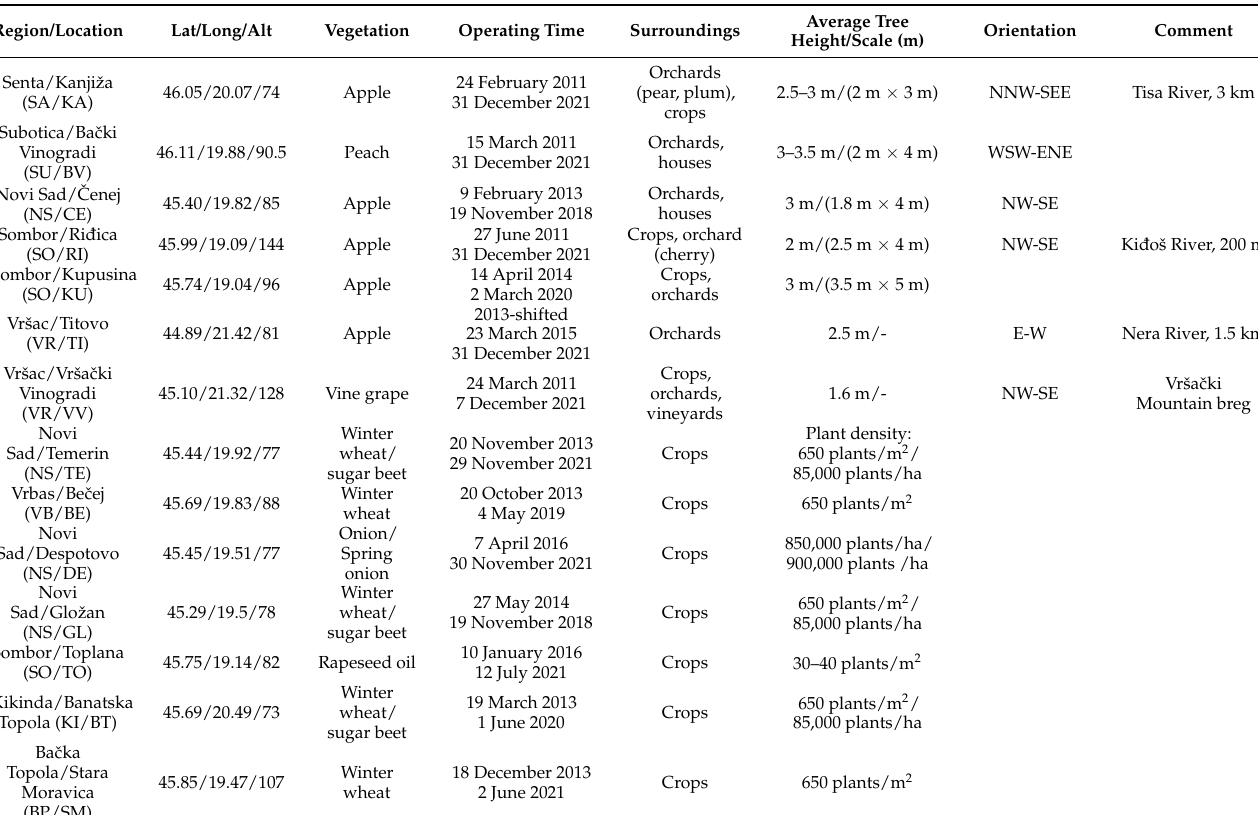
Table 1. Selected